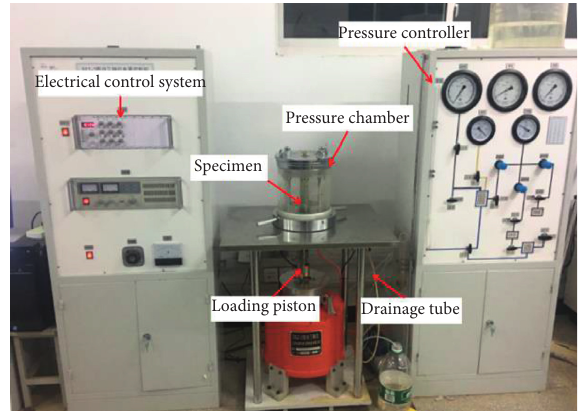
Figure 2: Photograph of the DSZ-2 dynamic triaxial